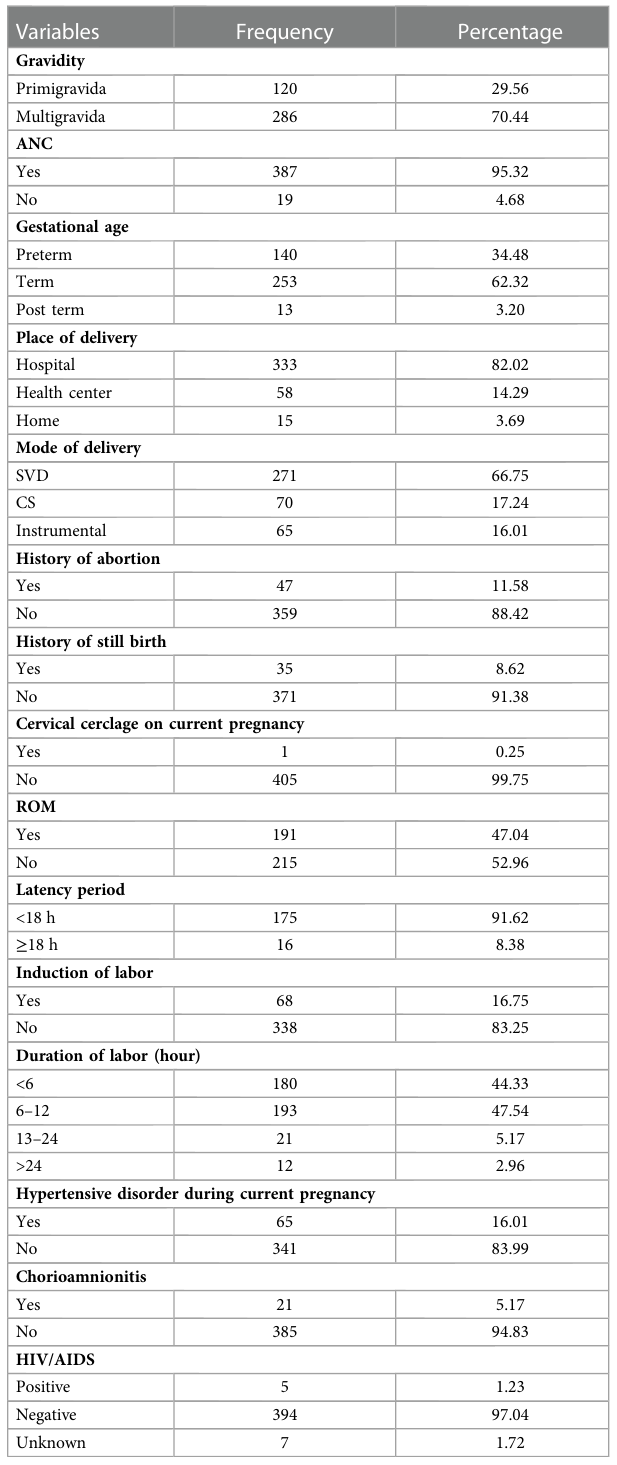
with sepsis at NICU in referral hospitals of northwest Ethiopia, 2021 ( N